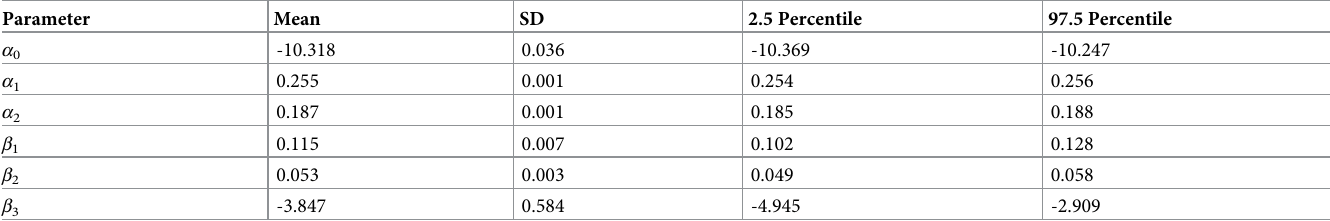
Table 7. New Jersey daily count data model 5B posterior mean parameter estimates.